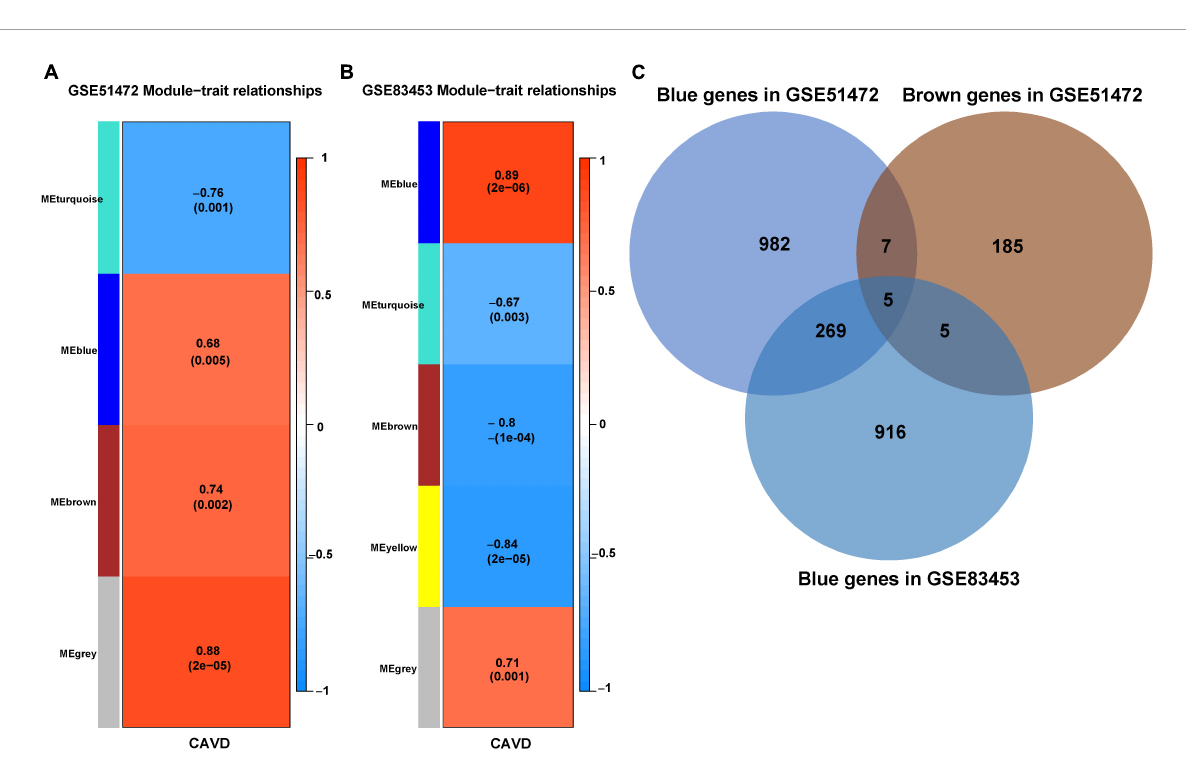
FIGURE4 Identification of feature genes in CAVD datasets. (A) Module–phenotype relationships in CAVD dataset GSE51472. Each cell contains the corresponding correlation and p -value. (B) Module–phenotype relationships in CAVD dataset GSE83453. Each cell contains the corresponding correlation and p -value. (C) Venn diagram of the feature genes in two datasets, GSE51472 and GSE83453, identified a total of 279 up-regulated feature genes, with different colors representing different